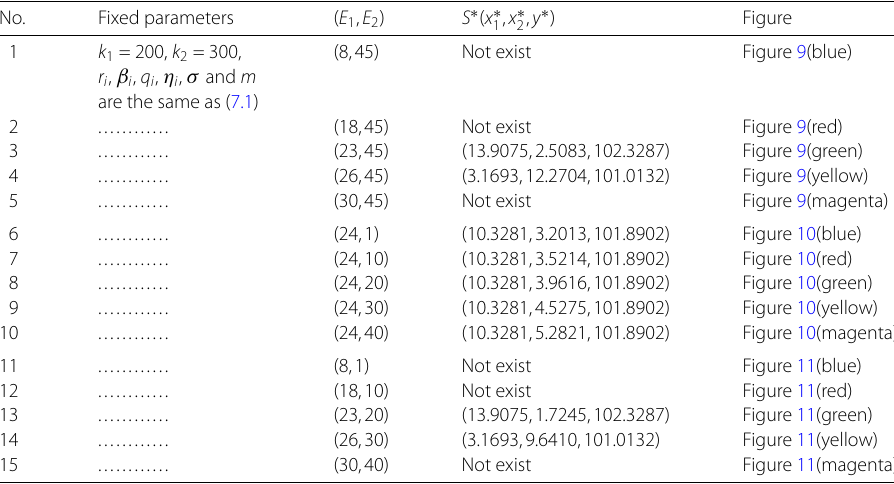
Table 2 The parameter values of E 1 and E 2 used in Figures 9, 10, 11